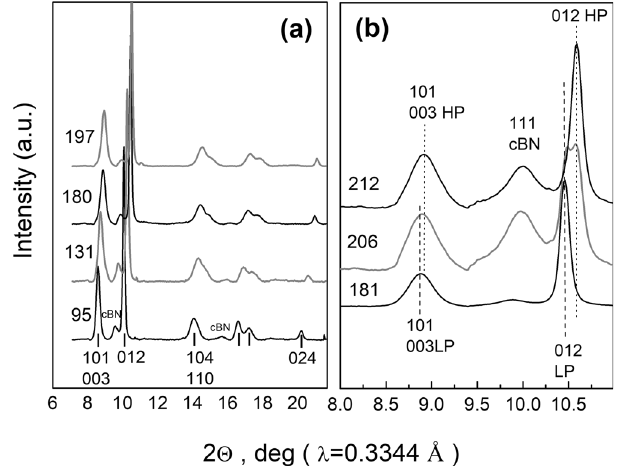
Fig. 5 The X-ray diffraction patterns of NiO in non-hydrostatic experiment in the megabar pressure range. a The evolution of X-ray diffraction (XRD) patterns of NiO in run5 with pressure increase below the structural transition. b The evolution of XRD patterns of NiO in run5 with pressure increase in the region of structural transition (181 – 212 GPa).